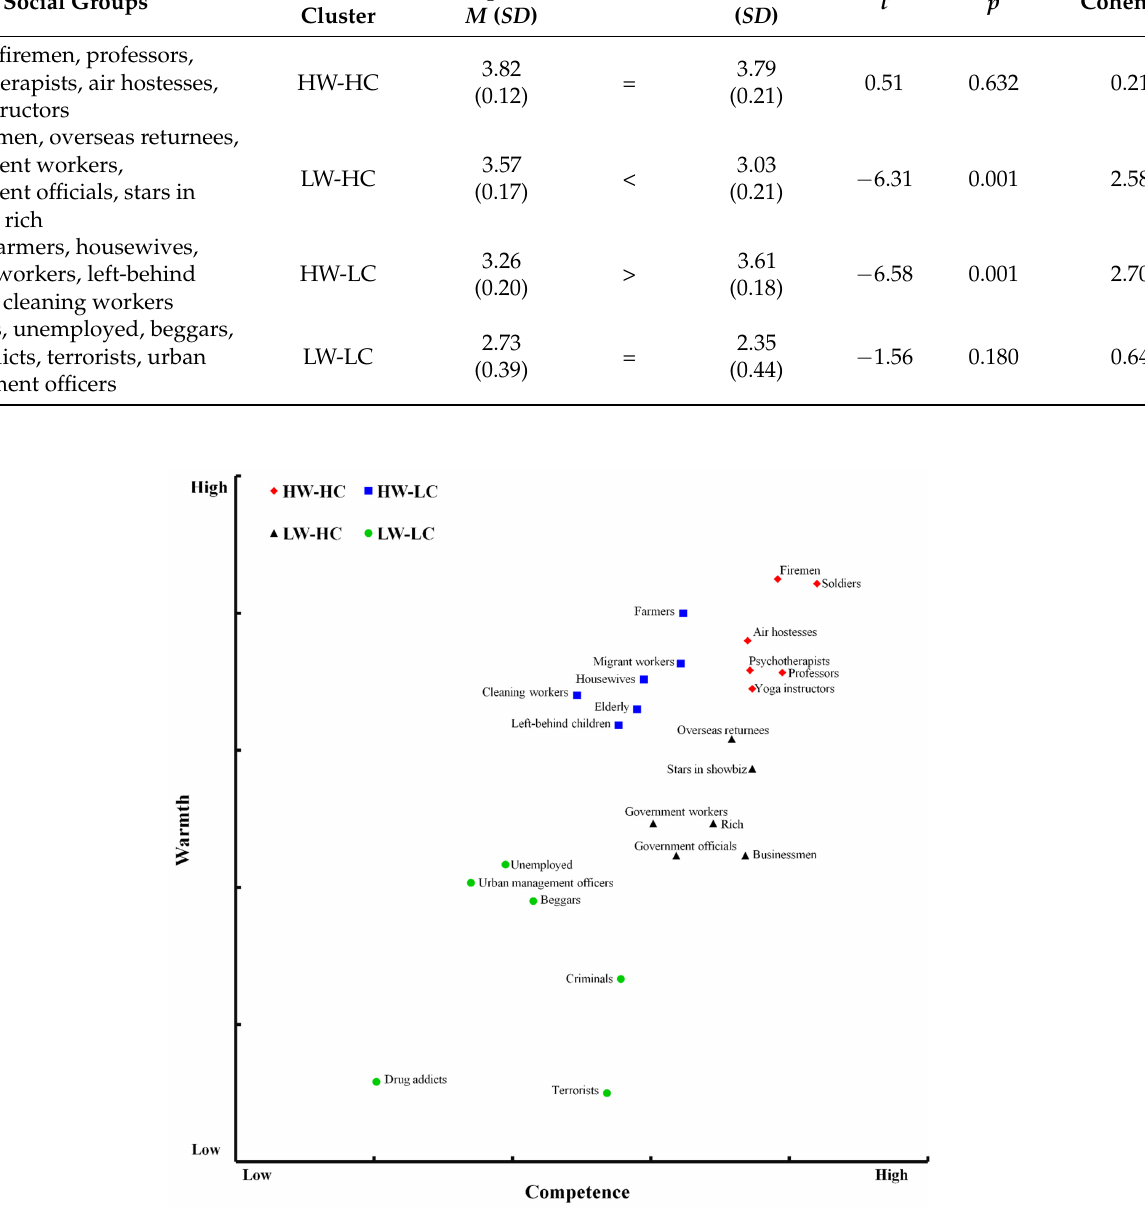
Table 6. The descriptive data and paired t -test results of warmth and competence for four social group clusters (based on 24 groups). Label of Social Groups Cluster